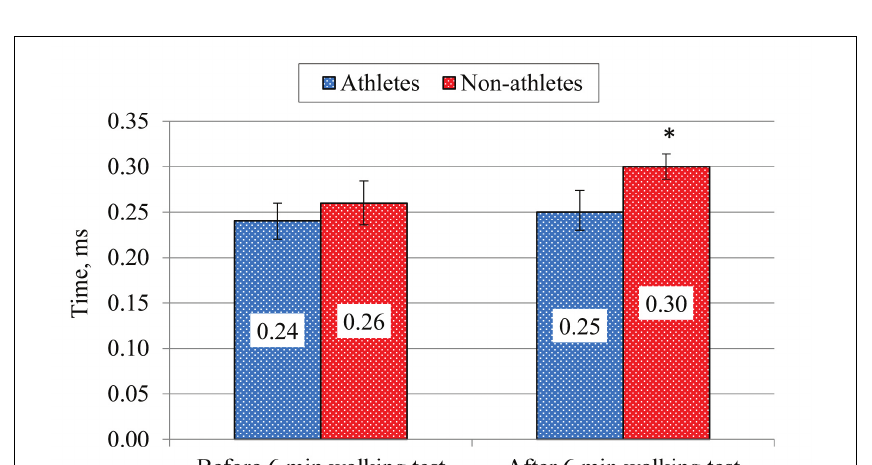
Note. r = .900, p < .05.